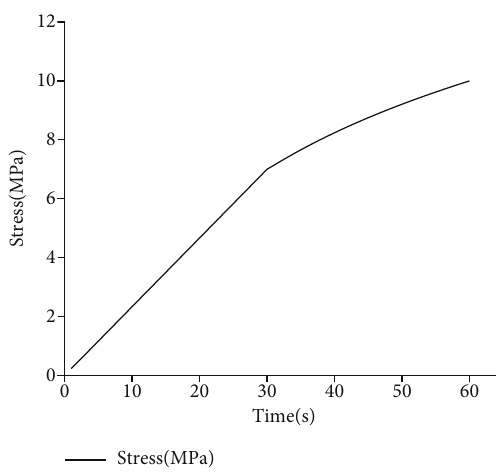
Figure 10: Variation curve of loading